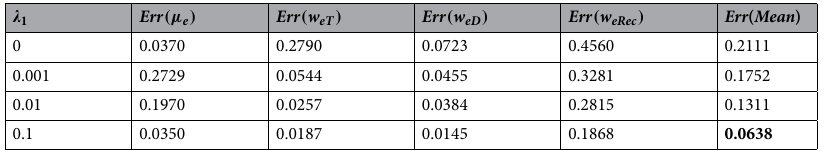
Table 4. Error values for Physical Model-4 with different (cid:31) 1 values. Err (µ e ) , Err ( w eT ) , Err ( w eD ) , Err ( w eRec ) are the error values in the drift, trapping, detrapping and recombination coefficients of the electrons respectively. Err ( Mean ) is the arithmetic mean each of these error values. Significant values are in [bold].